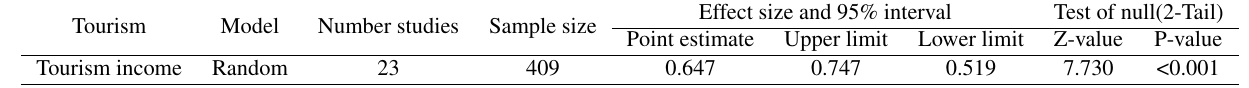
Table 2 The random effect model analysis of tourism revenue and economic